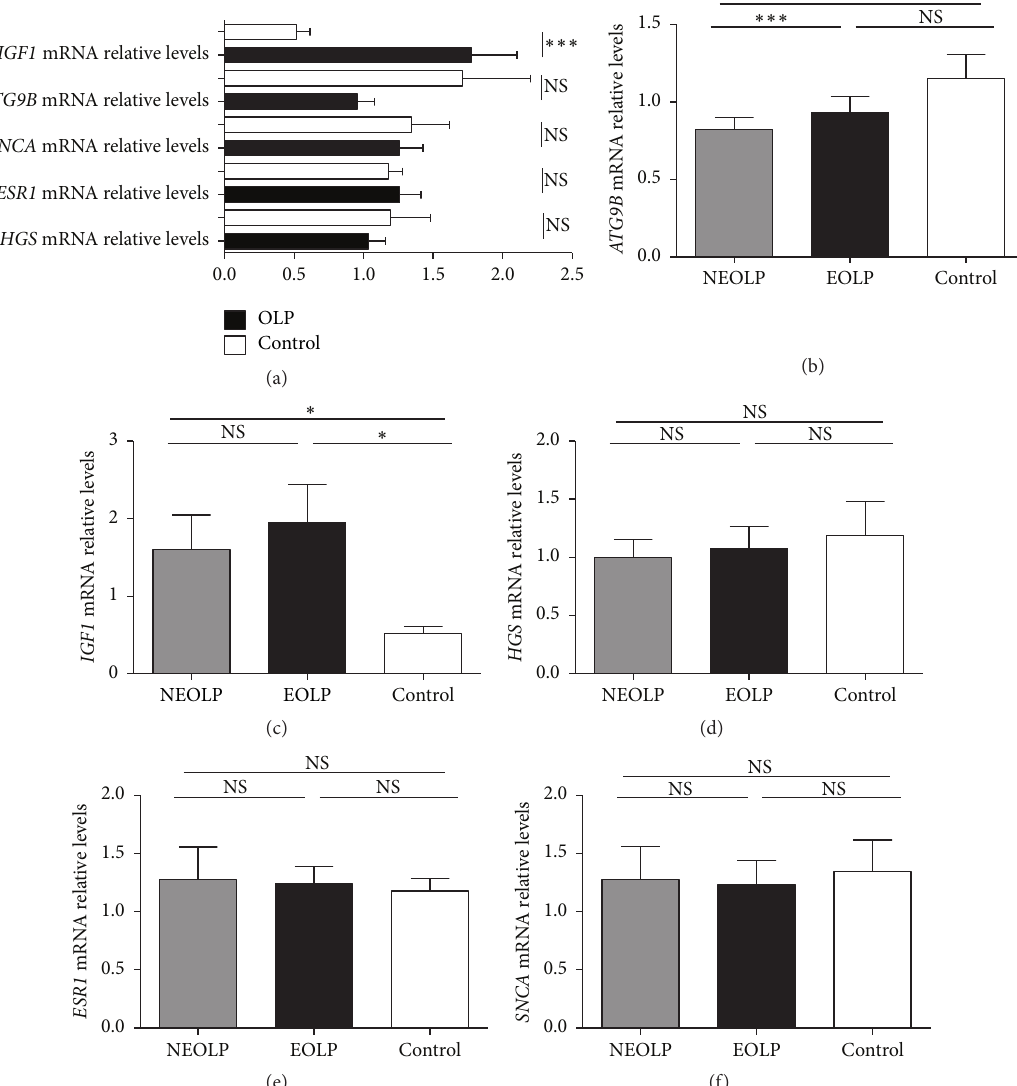
Figure 3: Expression of IGF1 , ATG9B , HGS , ESR1 , and SNCA of T cells in OLP patients and controls. (a) Expression of IGF1 , ATG9B , HGS , ESR1 , and SNCA mRNA in T cells of OLP patients ( 𝑛 = 22 ) and controls ( 𝑛 = 10 ). (b–f) The mRNA expression of IGF1 , ATG9B , HGS , ESR1 , and SNCA in nonerosive OLP patients (NEOLP, 𝑛 = 11 ), erosive OLP patients (EOLP, 𝑛 = 11 ), and healthy controls ( 𝑛 = 10 ). Data were shown as mean ± SEM ( ∗∗∗ 𝑝 ≤ 0.001 , ∗ 𝑝 < 0.05 , NS: nonsignificantly).